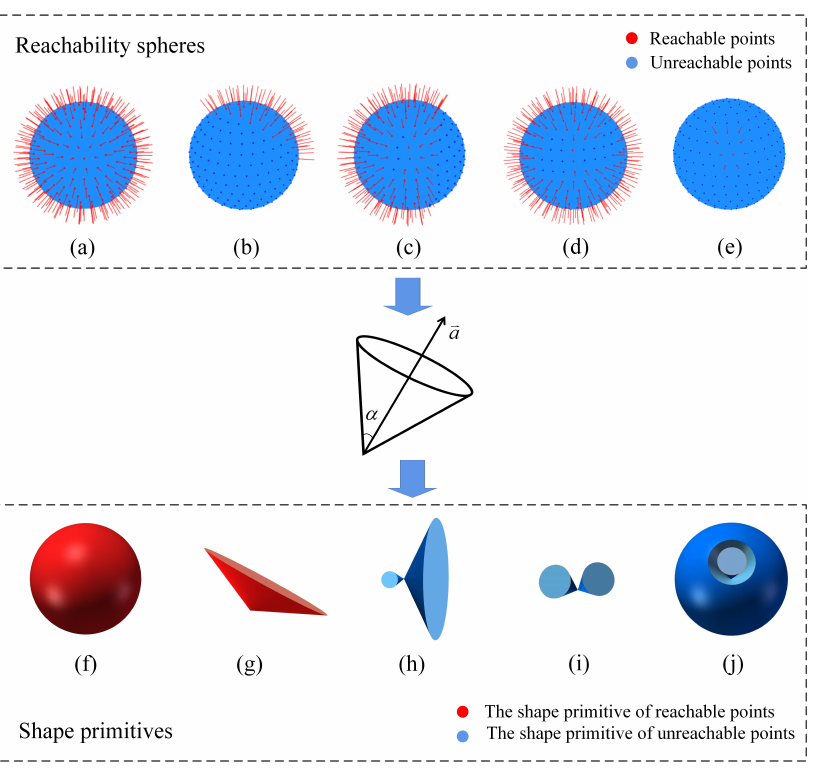
Figure 9. ( a – e ) represent five representative reachability spheres and ( f – j ) represent their correspond- ing shape primitives; the middle of the figure represents a cone-like shape primitive in our